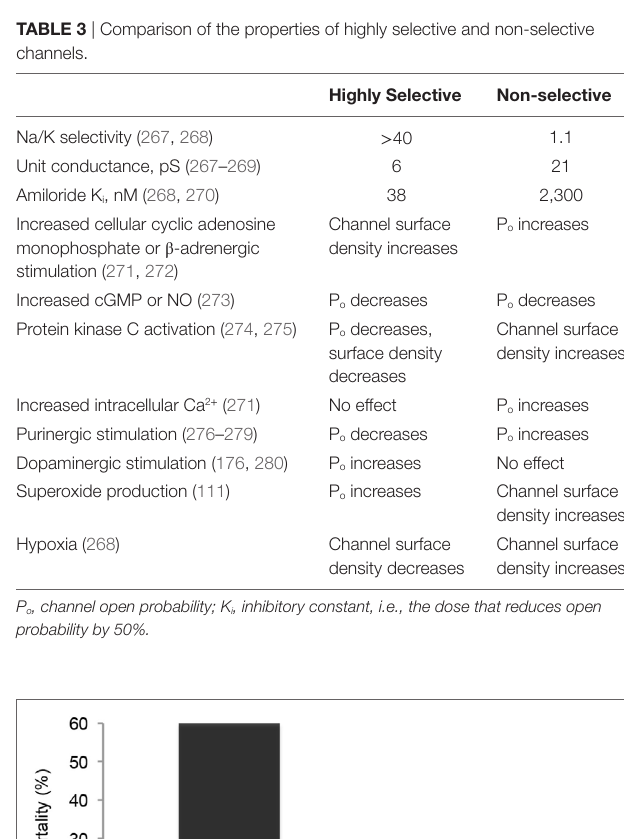
TAbLe 3 | Comparison of the properties of highly selective and non-selective channels.